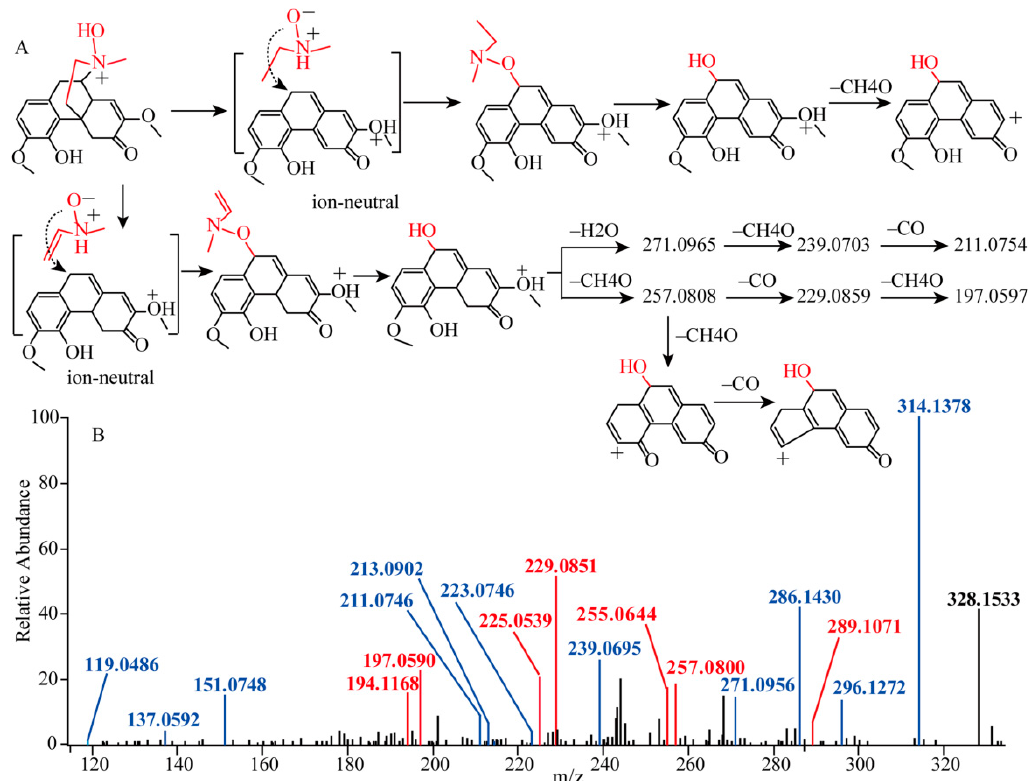
Figure 5. ( A ) the fragmentation pathway of the produced ion-neutral complex intermediate, ( B ) the MS 2 spectrum of the sinomenine N -oxide, the ions in blue suggested the same fragments with sinomenine, the ions in red suggested the special fragments generated from the ion-neutral complex intermediate.